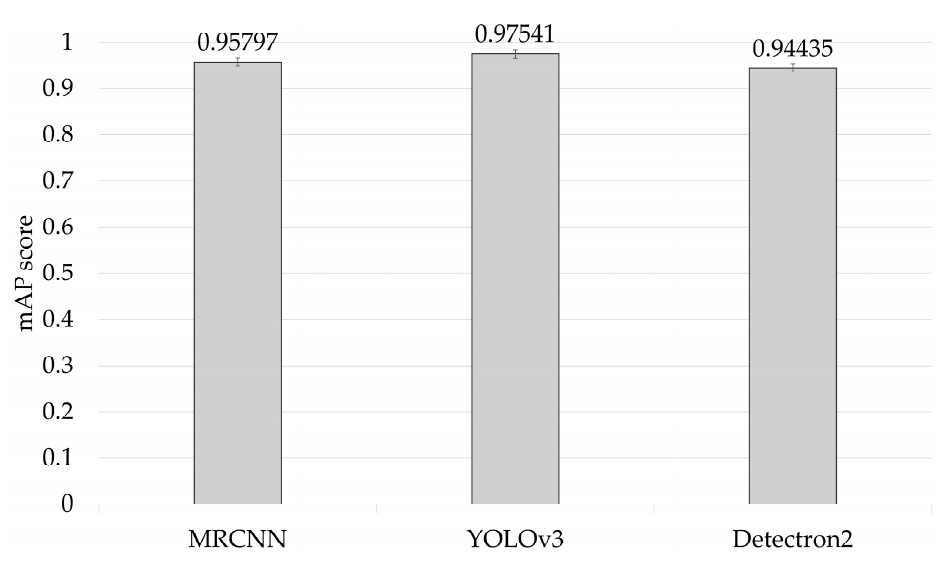
and Detectron2 had the lowest of 0.94435 (Figure 9).